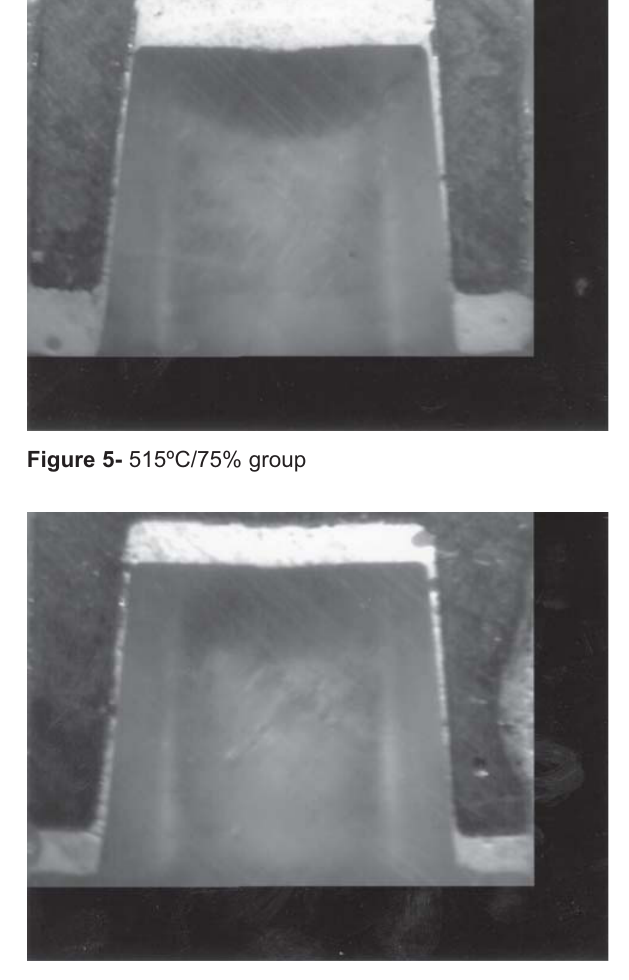
FIGURE 6- 600ºC/100%